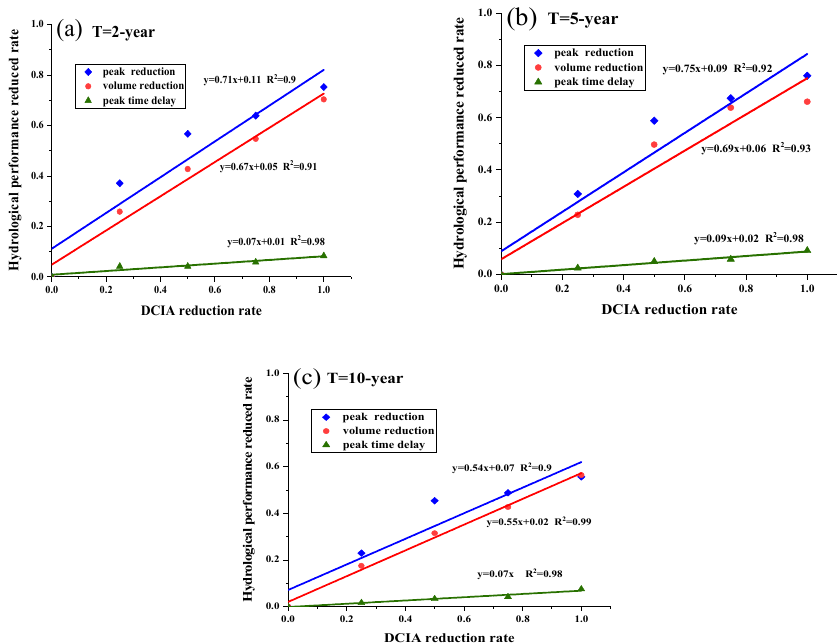
Figure 12. The effect of DCIA on hydrological performance for rainfall events of three return periods: ( a ) T = 2-yesr; ( b ) T = 5-year; ( c ) T = 10-year.